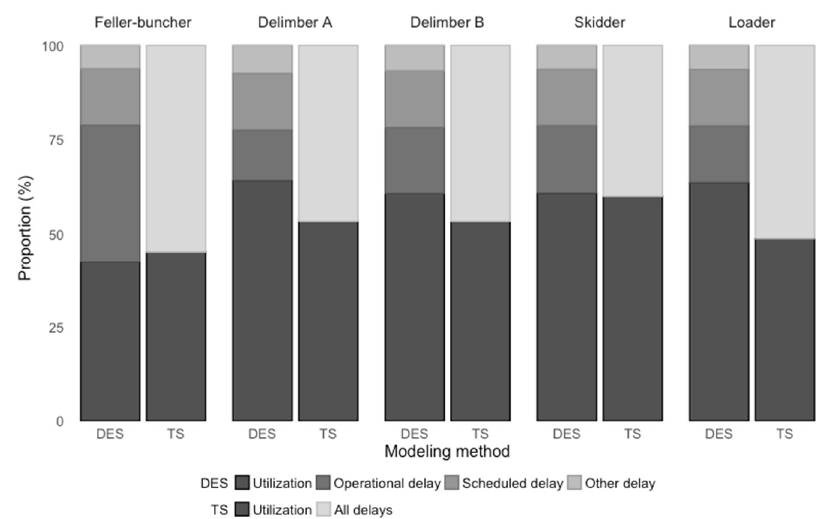
Figure 6. Machine utilization and delay proportions estimated by the WT DES and WT TS models.